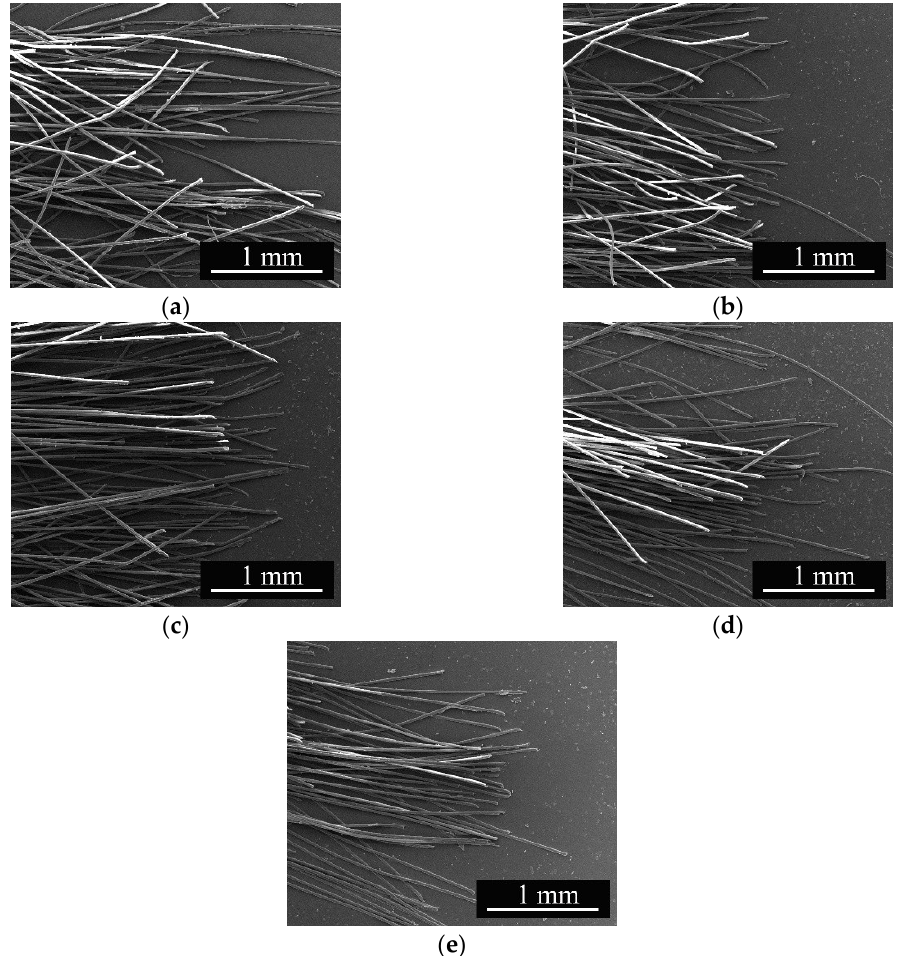
Figure 6. SEM images of failure modes at the strain rates of 1 / 600 s − 1 ( a ); 40 s − 1 ( b ); 80 s − 1 ( c ); 120 s − 1 ( d ); 160 s − 1 ( e ).